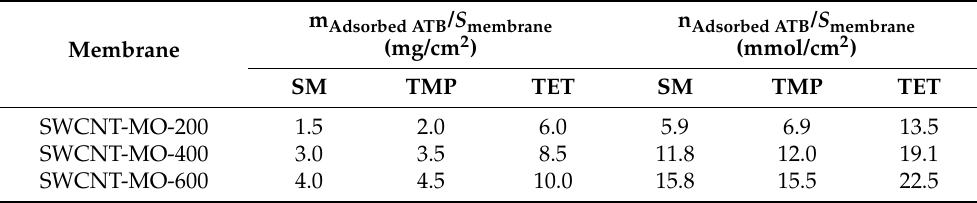
Table 9. Weight of adsorbed ATBs (SM, TMP, and TET) and amount of substance per area of the membrane after saturation of the SWCNT membranes.